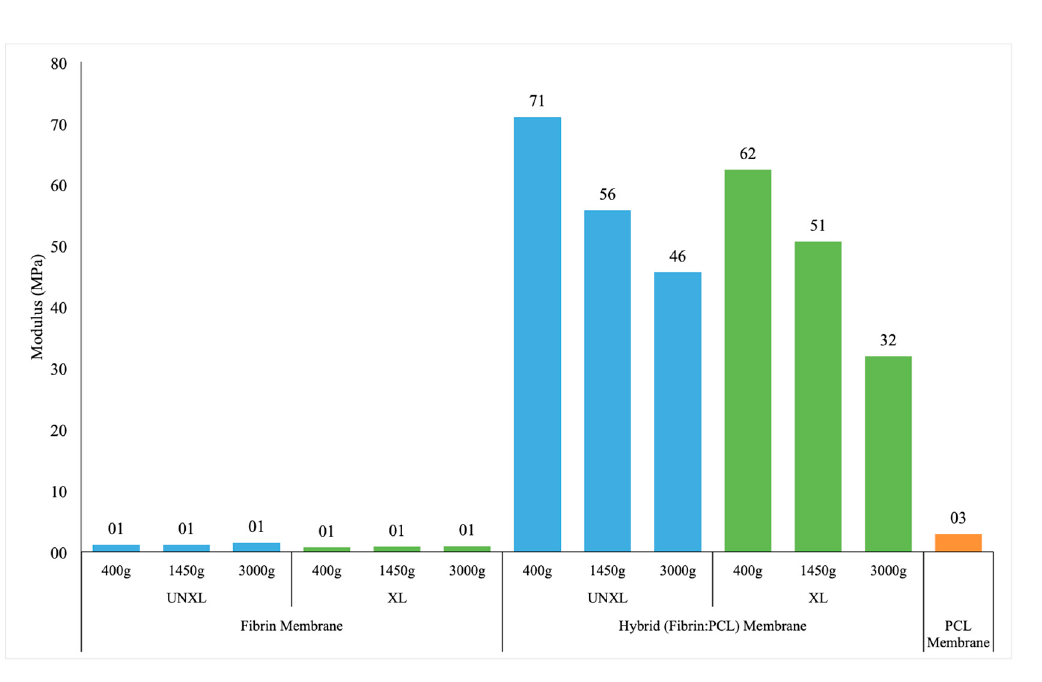
Figure 6. Energy to break of fibrin membrane, hybrid membrane and pure PCL membrane. Data shows extremely fragile fibrin matrices when compared the electrospun PCL membrane. Hybrid